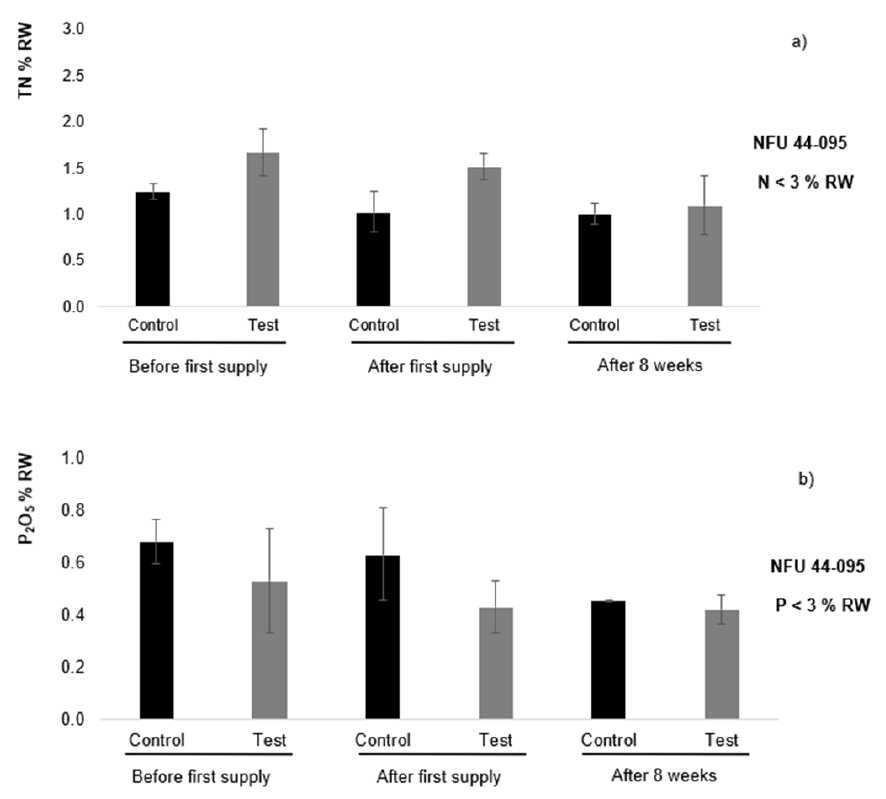
Figure 6. The agronomic parameters ( a ) TN (% RW) and ( b ) P 2 O 5 (% RW) measured in the two biopiles: Control (biopile watered with clean water) and Test (biopile watered with leachate), n = 3.